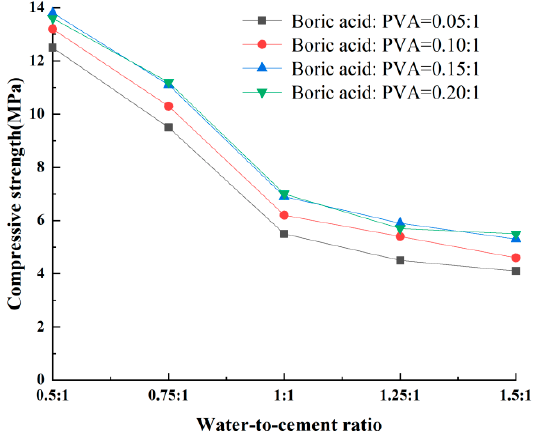
Figure 7. The influence of the water–cement ratio and boric acid on compressive strength.